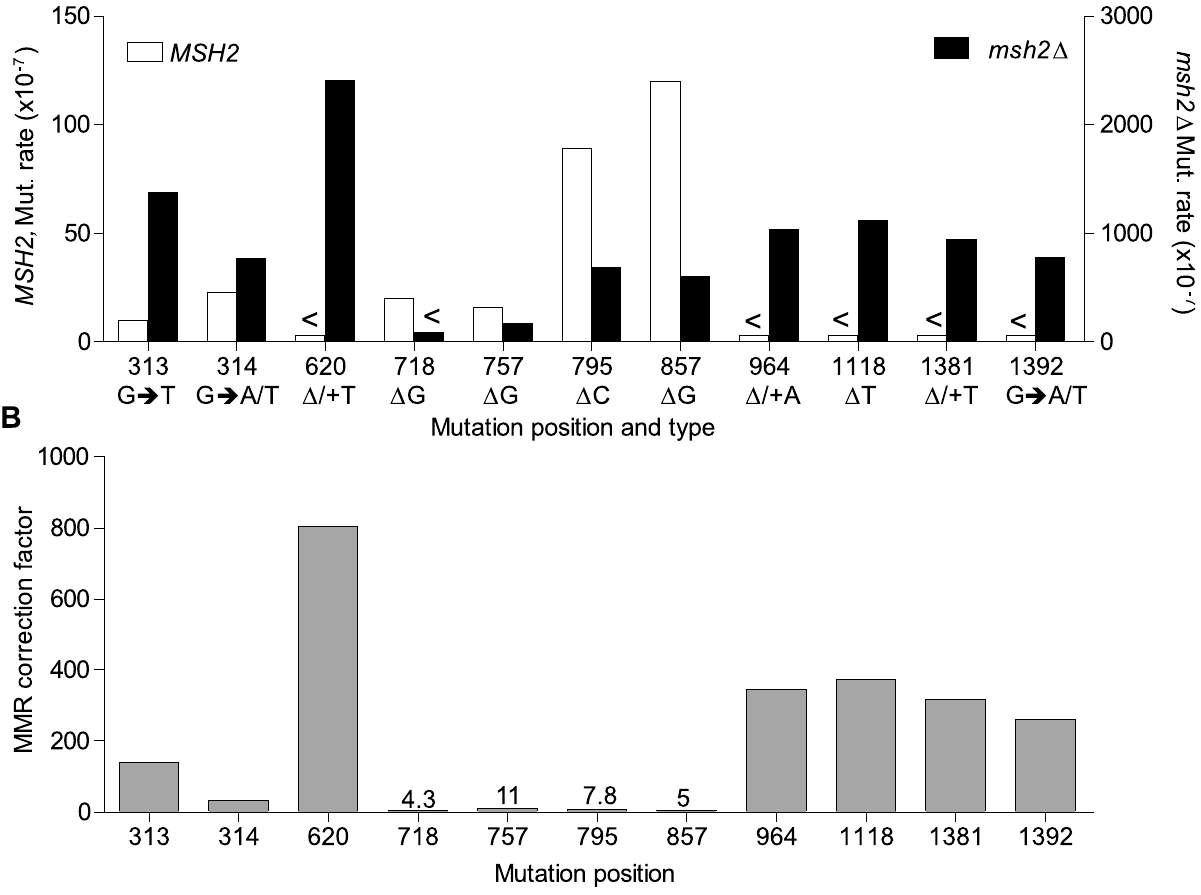
Figure 6. Mismatch repair efficiency. A. Comparison of site mutation rates at major hotspots in rnr1-Y285A with (left axis) and without MMR (right axis). B. MMR correction factor at these sites in the presence of an rnr1-Y285A dNTP pool imbalance. , Denotes no events